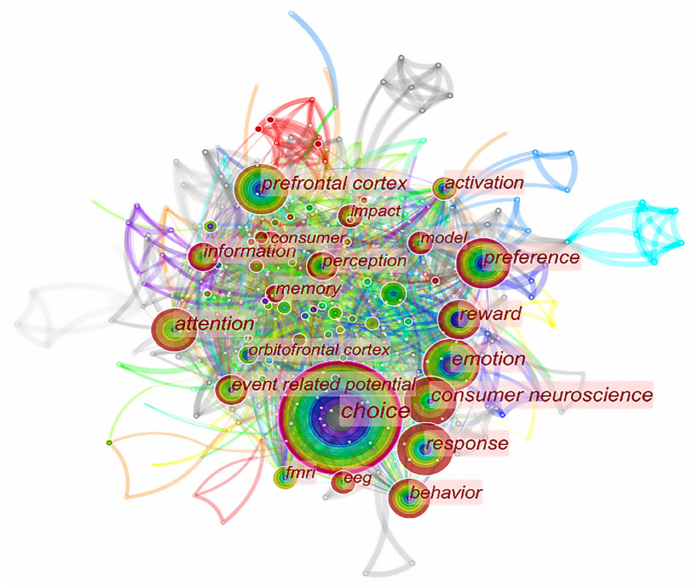
Figure 3. Keyword co-occurrence network.